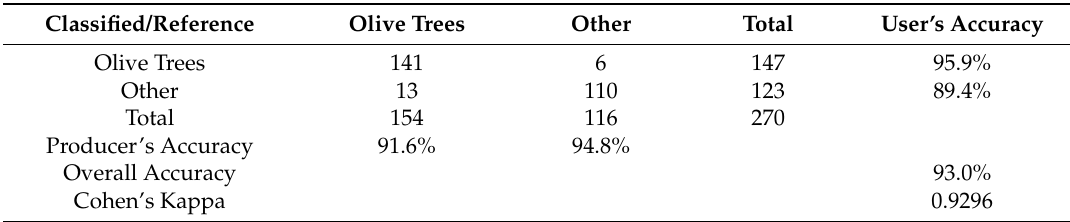
Table 1. The error matrix of the classification test.